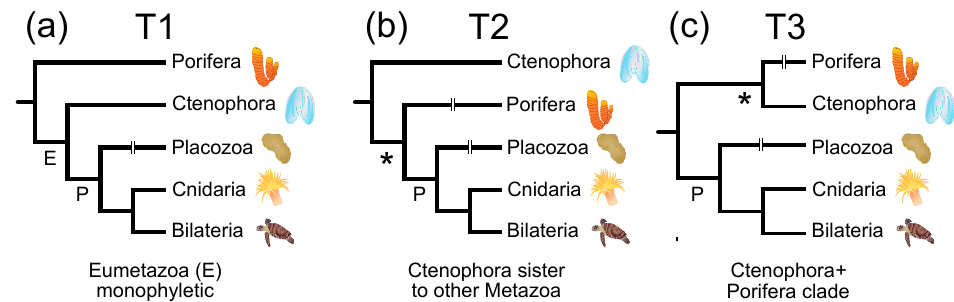
Figure 1. Topologies for the deepest branches in the metazoan tree recovered in phylogenomic analyses. ( a ) Porifera (sponges) sister to all other metazoa. This hypothesis includes a clade designated Eumetazoa (E). ( b ) Ctenophora (comb jellies) sister to all other metazoa. ( c ) A sponge+ctenophore clade sister to all other animals. All trees shown include a clade named Parahoxozoa (P) [43]. The